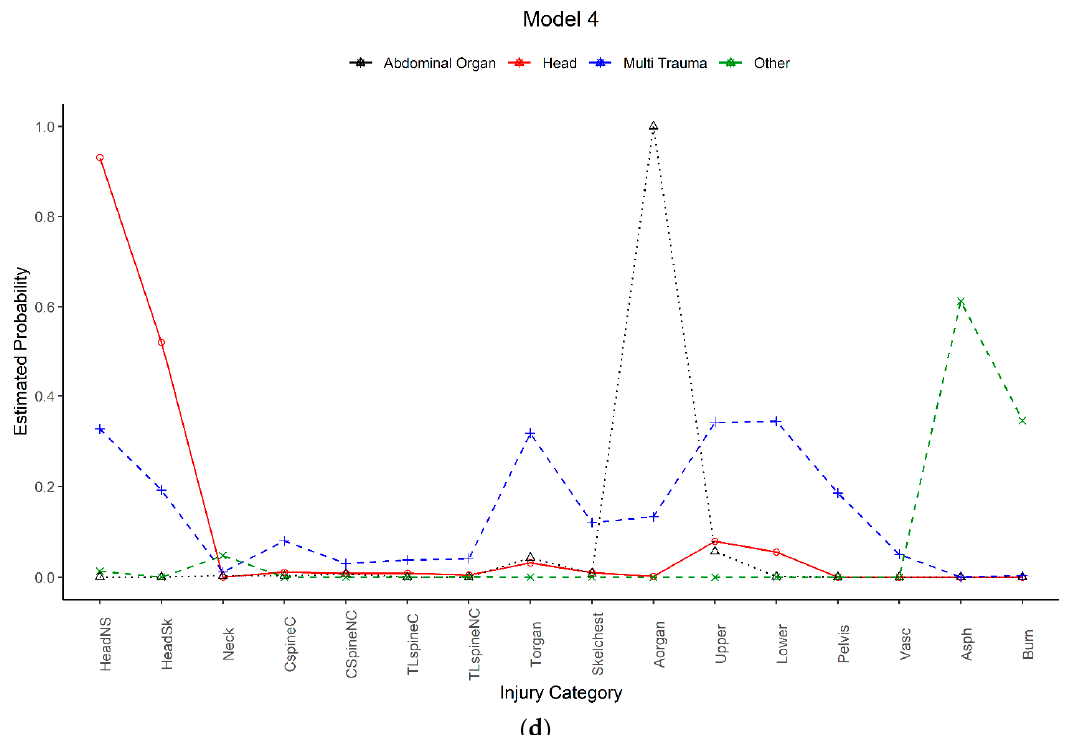
Figure 3. Estimated probabilities of Latent Classes ( a ) Model 1 (M1); ( b ) Model 2 (M2); ( c ) Model 3 (M3); ( d ) Model 4 (M4). Note: HeadNS = Head-brain injury, HeadSK = Head-skull fracture, Neck = Neck injuries, CspineC = Cervical spine–spinal cord injury (SCI), CSpineNC = Cervical spine–non-SCI, TLspineC = Thoracolumbar spine—SCI, TLspineNC = Thoracolumbar